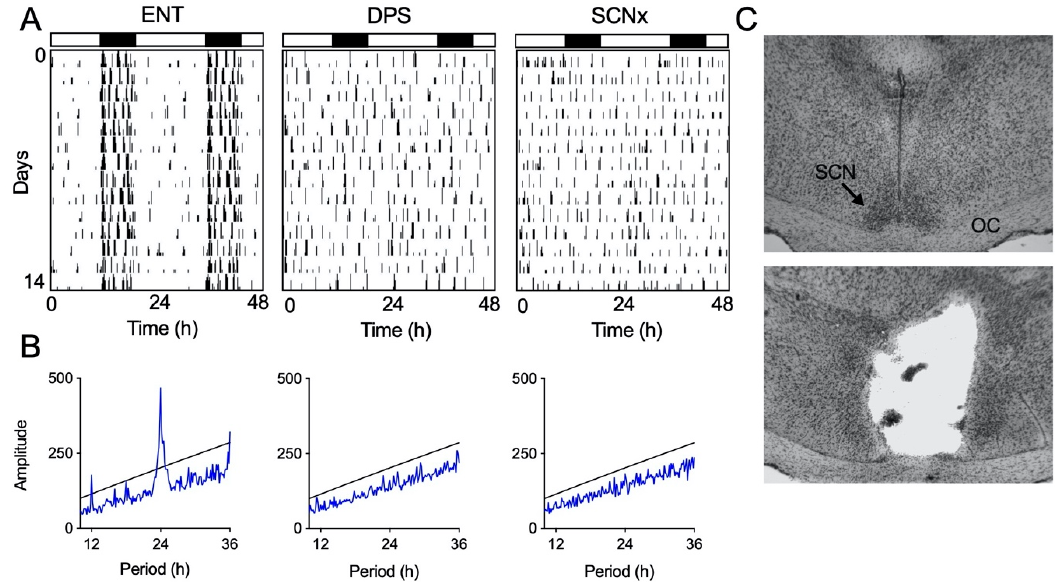
Figure 2. Representative examples of locomotor activity patterns. Actograms show locomotor rhythm entrainment (ENT; A ) or circadian arrhythmia from the DPS protocol (DPS; A ) or brain lesions (SCNx; A ). ENT and DPS actograms are from the same animal. Vertical black hash marks indicate movement in the cage; consecutive days are double-plotted. Black and white rectangles indicate night (8 h) and day (16 h), respectively. Periodogram analysis ( B ) confirming a lack of periodicity in DPS and SCNx animals. Peaks above the black line are statistically significant ( p < 0.001). Representative Nissl-stained sections ( C ) from intact (top) and SCNx (bottom) hamsters; optic chiasm (OC).